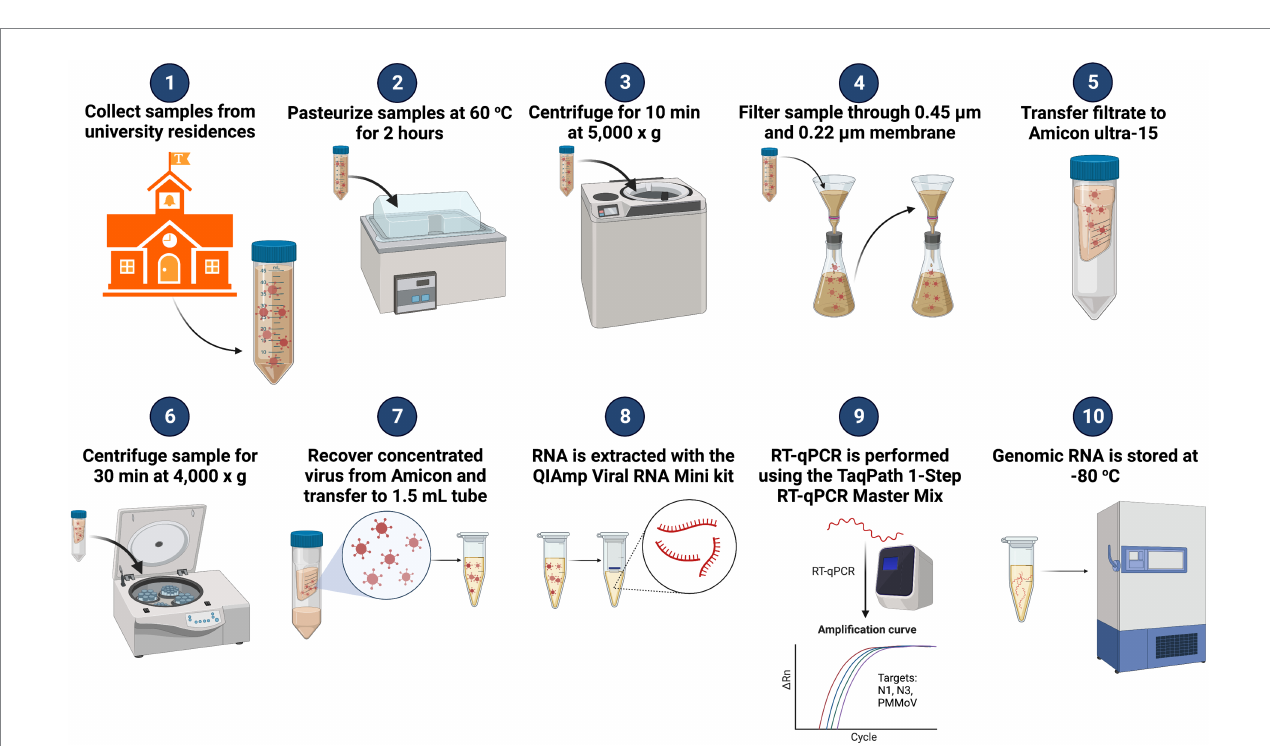
FIGURE 2 Diagram of WBE workflow for SARS-CoV-2 surveillance on the University of Tennessee-Knoxville campus. Adapted from “Quantifying SARS-CoV-2 Virions in City Wastewater,” by BioRender.com (2022). Available at: